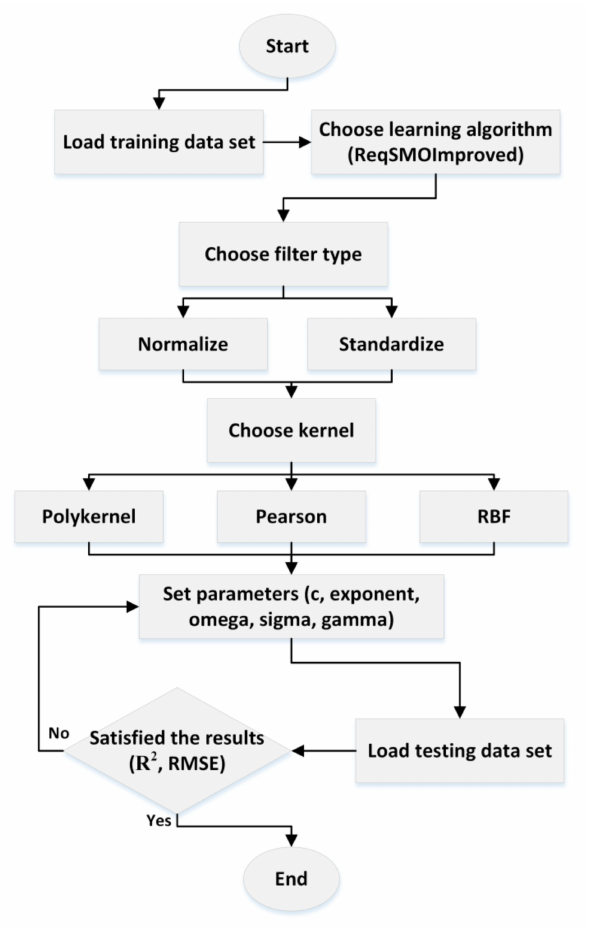
Figure 2. The workflow of support vector machine